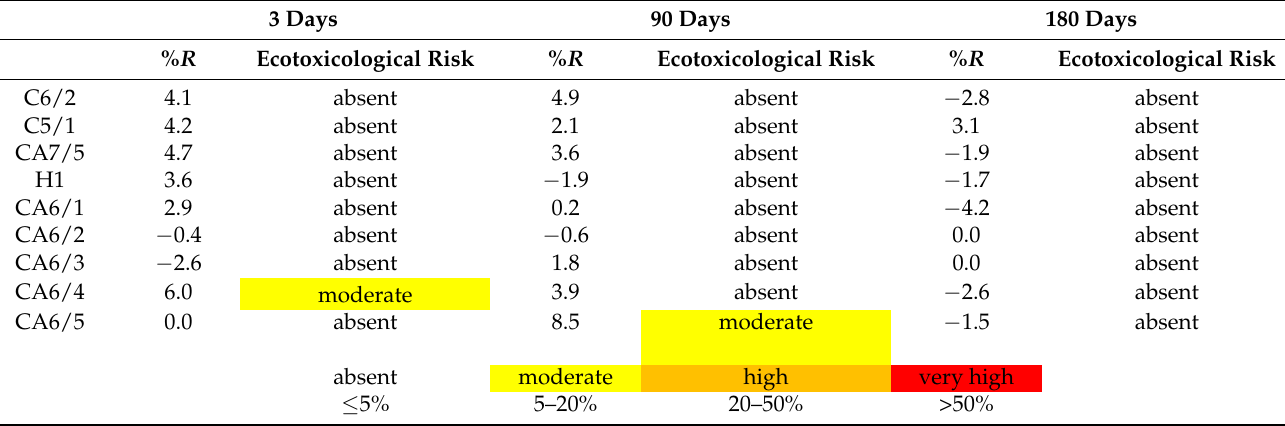
Figure 1. Biological responses of the different model species exposed to glitter leachate in freshwater according to the different soaking times: 3, 90 and 180 days. The dashed line refers to the reference threshold established by the method (15% for A. fischeri ; 20% for D. magna ; 10% for R. subcapitata) . Negative controls in plastic containers (CN/PL) are shown in black ‐ fill pattern (if not present, data were normalized using the Abbott formula; see Section 2.5). Table 2. Results after integration of values from bioassays performed in freshwater: percentage of ecotoxicological risk (%) and the corresponding ecotoxicological risk level (from absent to very